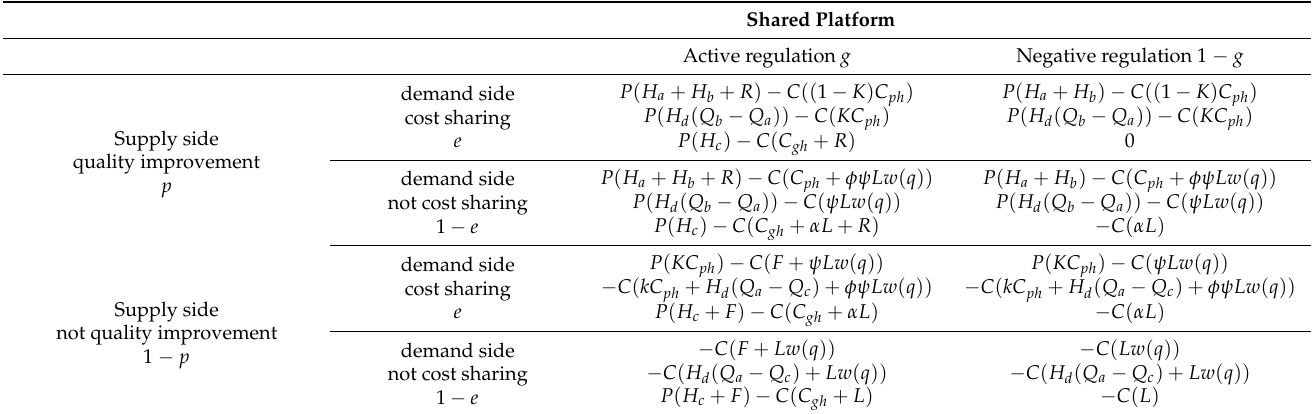
Table 1. Benefit Perception Matrix.